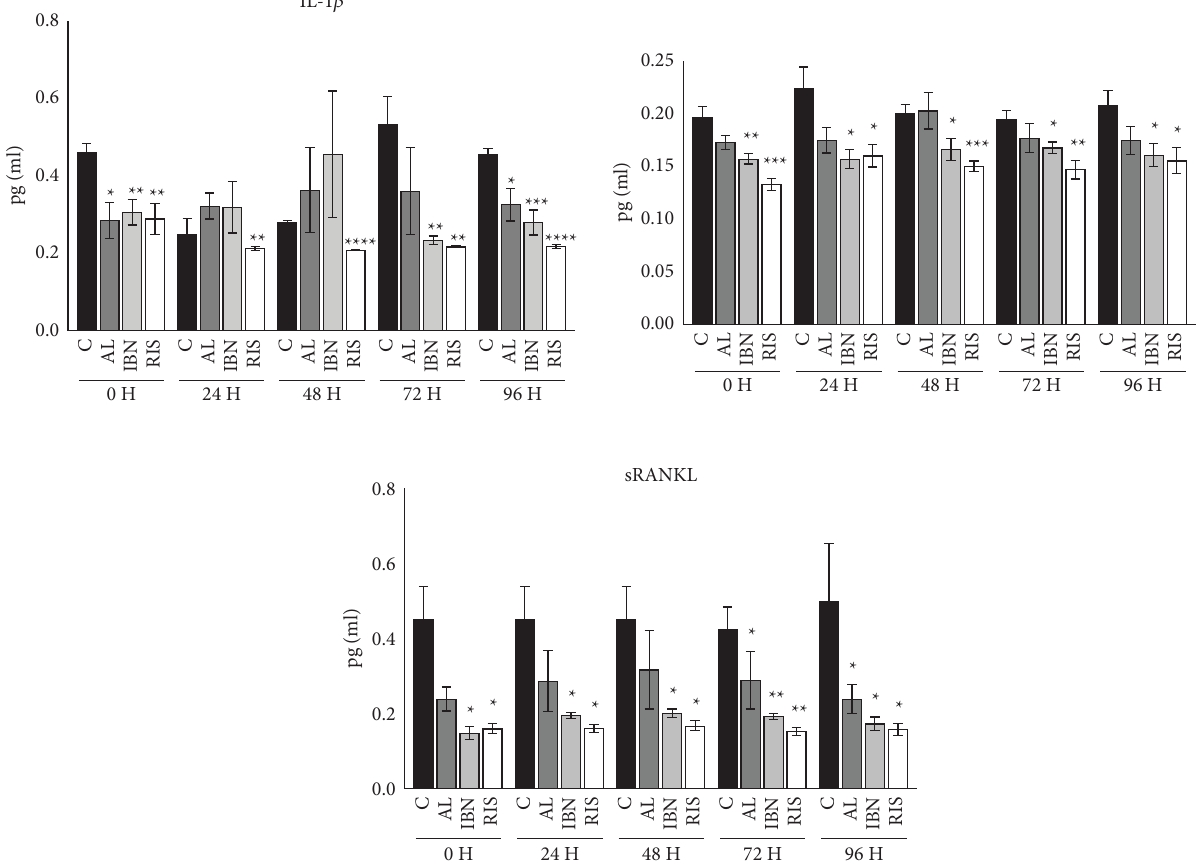
Figure 1: Osteoblast cultures were stimulated with nitrogen-containing bisphosphonates at 10 − 5 M for 0h, 24 h, 48h, 72h, or 96h, and the culture medium was analysed by ELISA to evaluate IL-1 β , TNF-, α and sRANKL production. Black bars represent the control cell group; AL: alendronate, IBN: ibandronate, and RIS, risedronate. Te results are expressed as the mean ± SD of 5 cultures. Signifcant diferences between the experimental and control groups: ∗ P < 0 . 01, ∗∗ P < 0 . 001, ∗∗∗ P < 0 . 001, and ∗∗∗∗ P < 0 .